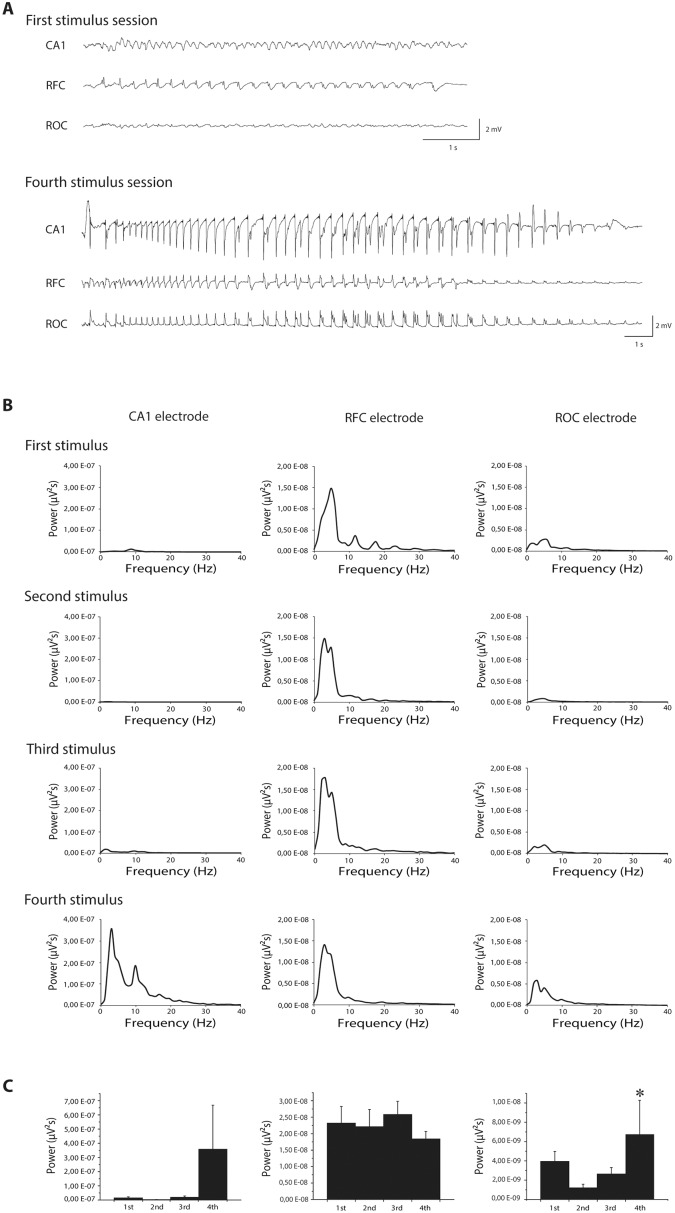
Modifications of ictal event induced by single or repeated stimulations.
(A) Electroencephalographic (EEG) traces showing ictal events after first corneal stimulation (upper traces) and after fourth stimulation (lower traces) in one representative mouse. Note that epileptiform activity is confined in the fontal cortex after the first stimulus and spreads to occipital cortex and hippocampus after four stimulations. (B) Mean power spectrum of ictal events recorded by depth electrode in CA1 and by epidural electrodes in frontal and occipital cortices, induced by up to 4 corneal stimulations. (C) Histograms illustrating power peaks show that ictal events do not change in frontal cortex after repeated stimulations (in each session n = 5 or 6). However, power peak of ictal events progressively increases going from first to fourth stimulation in CA1 (n = 2 or 3 for all sessions, not enough to reach statistical significance) and in occipital cortex (* = P<0.05, Friedman repeated measures analysis of variance; n = 4 or 5 for all sessions). CA1: Cornu Ammonis 1 (depth electrode); RFC: right frontal cortex; ROC: right occipital cortex.